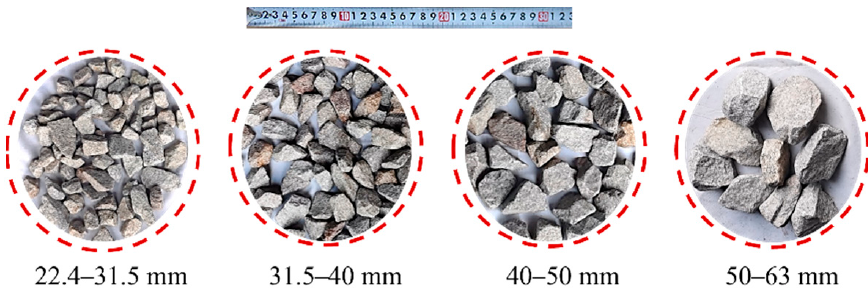
Figure 1. Illustration of the ballast particles within four different size ranges.